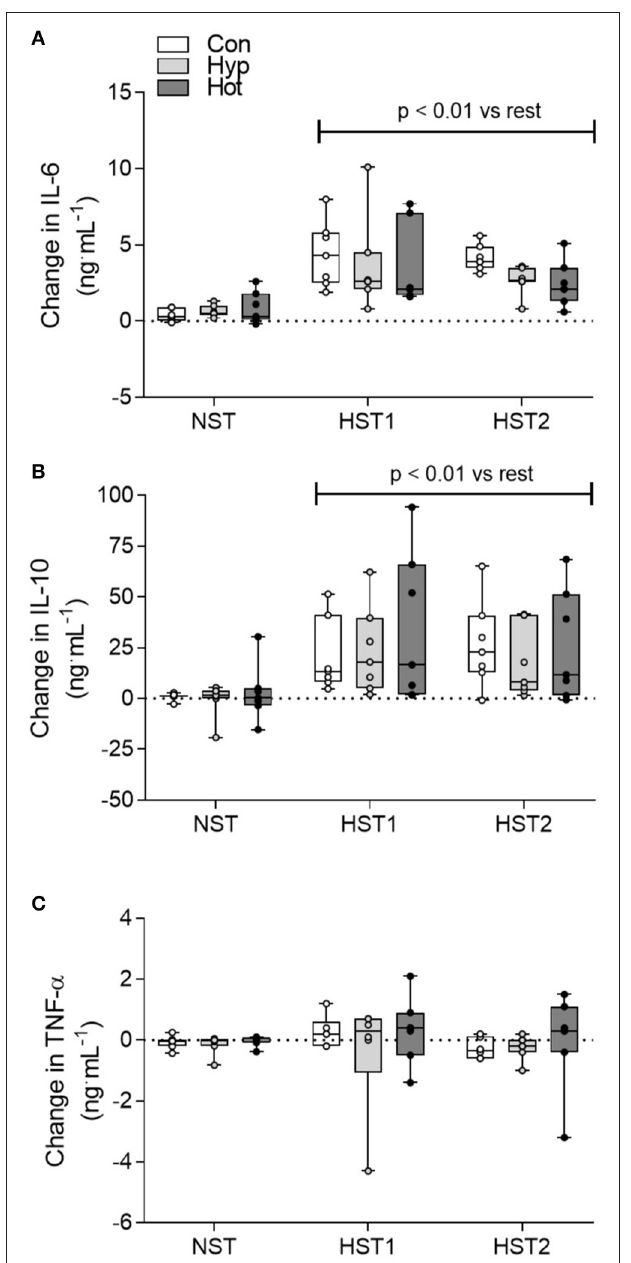
FIGURE 4 | Delta change (ng.mL − 1 ) in IL-6 (A) , IL-10 (B) and TNF- α (C) from pre to post-exercise for the NST, HST1, and HST2 trials. Box plots show all individual data points (dots), the 25 and 75th interquartile ranges (boxes), and the median (mid-line). Whiskers illustrate the highest and lowest value. P -values indicate differences relative to the pre-trial resting value within each experimental group and between normoxic and hypoxic conditions. are in the LTHA phase is experimentally important, yet no method exists to confirm this status in humans. Gibson et al.